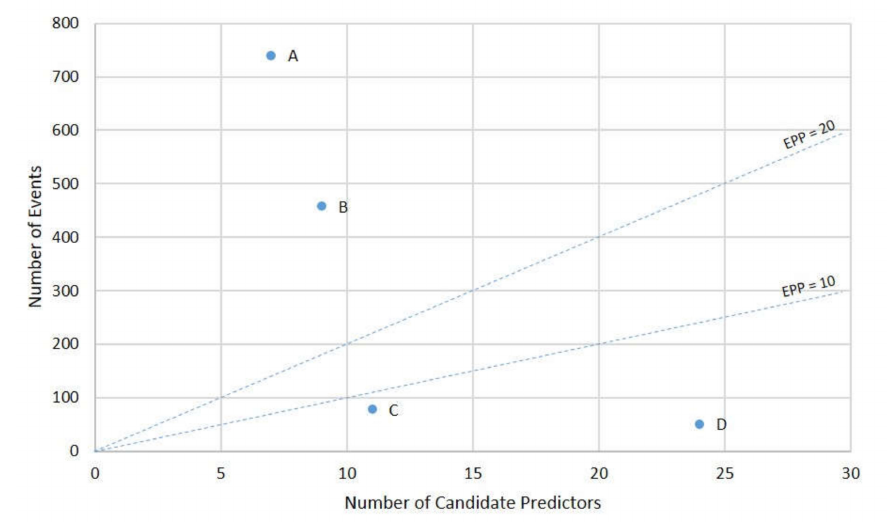
Figure 3. Events per predictor for prediction modelling studies for pregnancy complications in women with GDM. The events per predictor (EPP) are shown, where A indicates the EPP for Pintaudi et al. [24]; B, Park et al. [22]; C, Phaloprakarn and Tangjitgamol [23]; D, Tomlinson et al. [25]. The EPP could not be calculated for McIntyre et al. [21] An EPP above 10 to 20 is regarded as the minimum sample size for model development [19]. This graphical presentation format was adapted from Ensor and colleagues